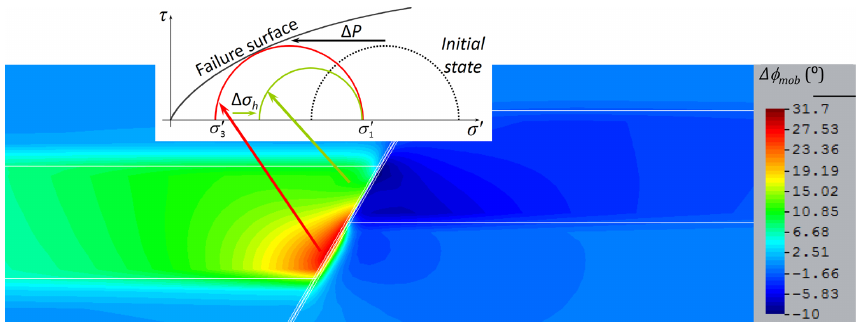
Figure 7. Distribution of stability changes induced by the pressure and stress changes shown in Fig. 6, measured in terms of the mobilized friction angle changes, (cid:49)φ mob . The inset shows the Mohr circles before and after reservoir